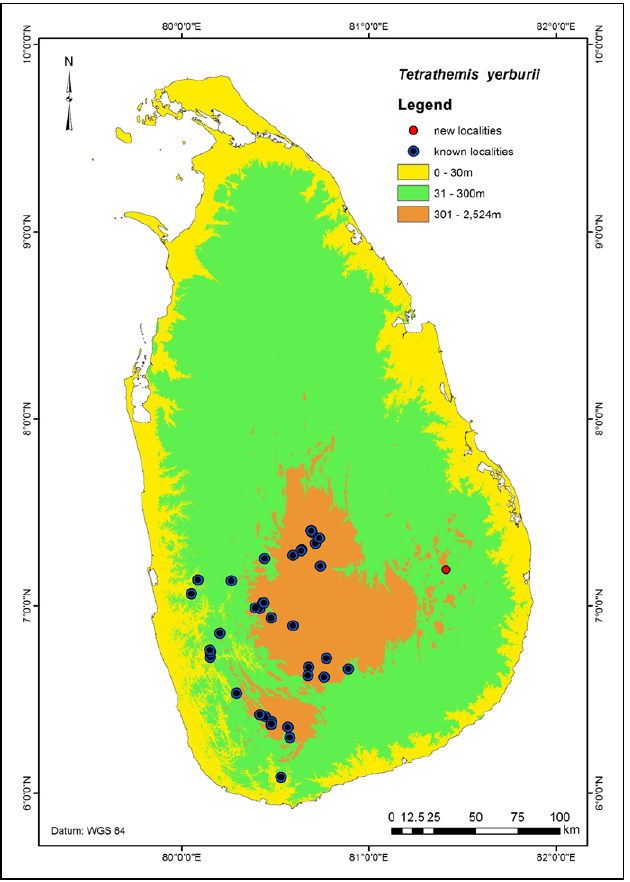
Figure 18. Distribution of Tetrathemis yerburii with new localities.